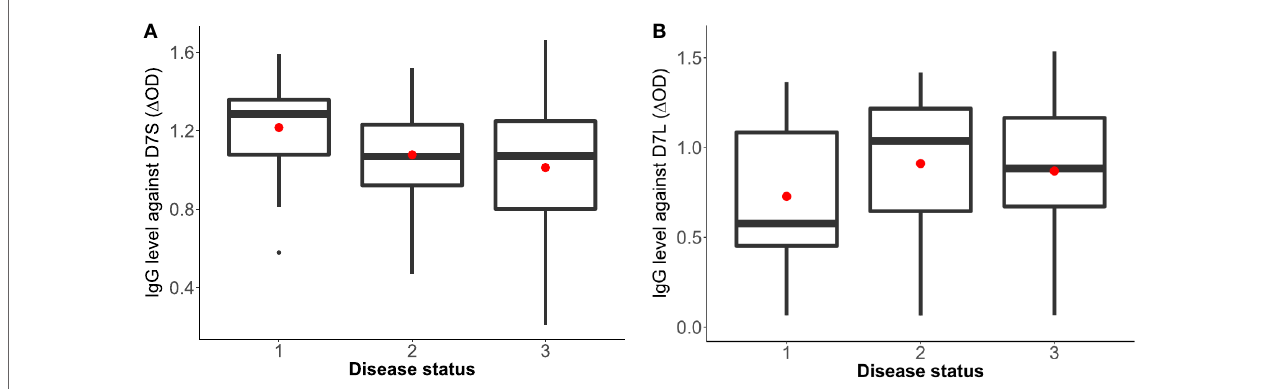
FigUre 1 | Human IgG antibody levels against Aedes aegypti D7 short (a) and D7 long (B) salivary proteins and disease status. Status 1: non-febrile, non-dengue virus (DENV) infected control subjects ( n = 12), status 2 febrile subjects ( n = 12), and status 3: DENV infected subjects ( n = 37). The red dot indicates the mean and the bars show the first and third quartiles with median as the